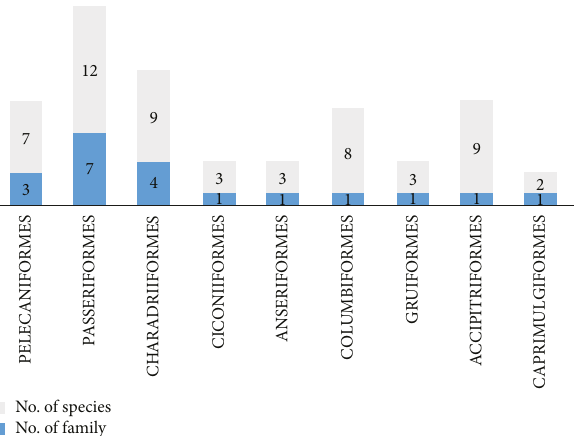
Figure 2: Family and species compositions of each order in the study sites during the study